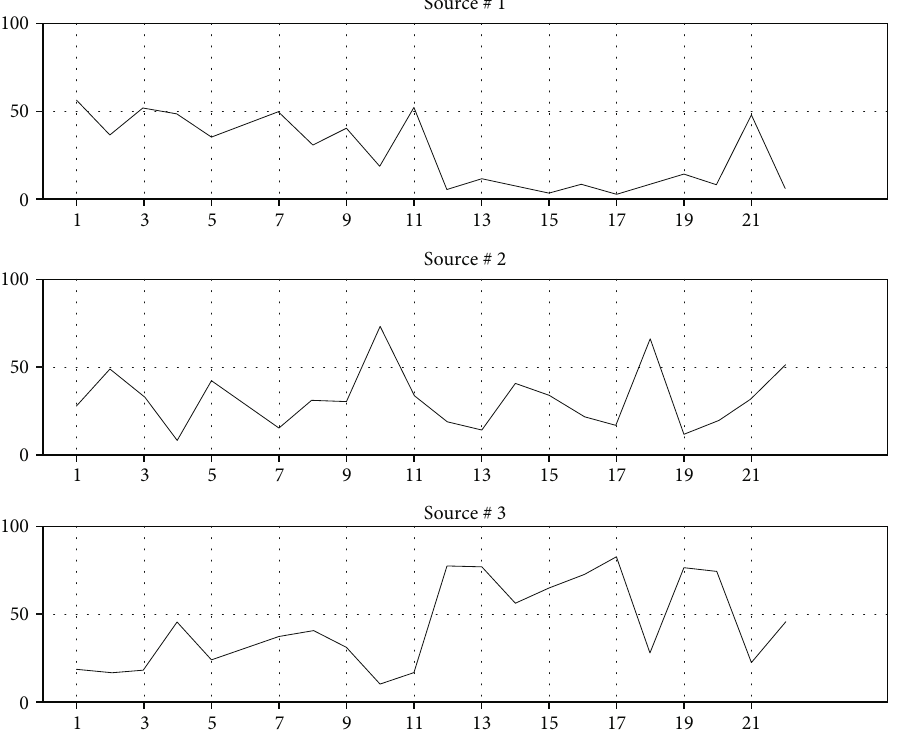
Figure 7: Variations of contribution Table 7: Results of Unmix model analysis.